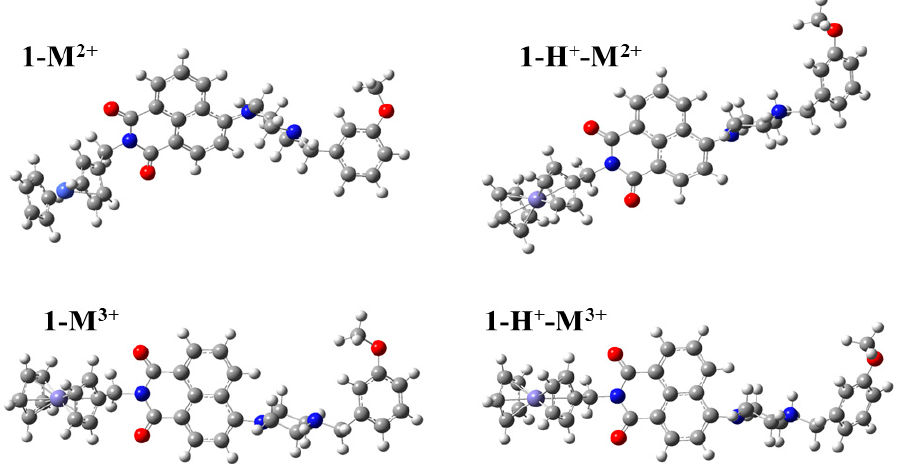
Figure 1. Calculated minimum structures at PBE0/6-31G(d,p). C atoms: grey balls, H atoms: white, O atoms: red; N atoms: blue; M (Fe, Co,Ni) atoms: O atoms: red; N atoms: blue; M (Fe, Co,Ni) atoms: violet.